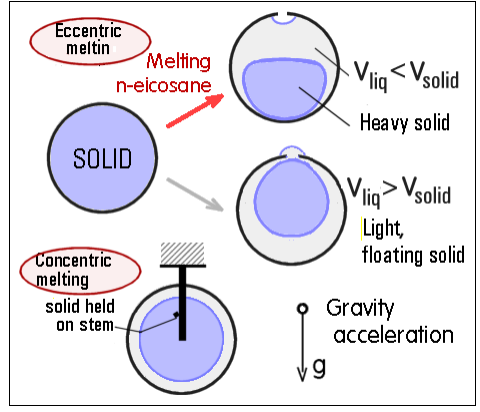
Fig. 6. Vertical positions the solid-state phase not yet molten material inside the spherical shell depends on the change of the specific volume during the melting. In the experiments, the n- eicosane in its liquid phase is lighter than the solid which thus falls to the shell bottom – unless it is fixed to a stem.